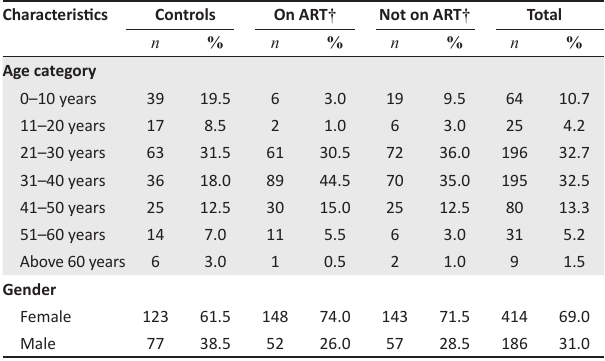
TABLE 1: Sociodemographic characteristics of controls, HIV - positive patients with and without antiretroviral therapy, Abuja, Nigeria in